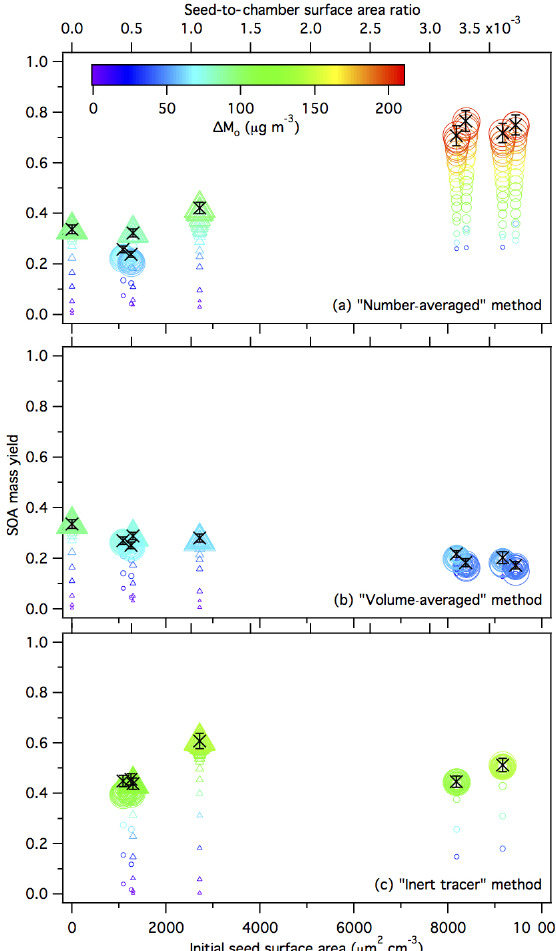
Figure 6. Averaged SOA mass yields over the course of an α - pinene ozonolysis experiment as a function of initial total AS seed aerosol surface area concentration using the (a) number-averaged, (b) volume-averaged and (c) inert tracer particle-wall deposition correction methods. Results from this study (15min averaged) are shown as circles, while results from the study by Nah et al. (2016) (10min averaged) are shown as triangles. Symbol color indicates the SOA mass concentration and symbol size indicates the time af- ter O 3 is injected into the chamber. The × symbols are the SOA mass yields at peak SOA growth obtained from the experimental data. The y axis error bars represent the uncertainty in the SOA mass yield at peak SOA growth, which originates from the α -pinene injection and the aerosol mass concentration at peak SOA growth (1 standard